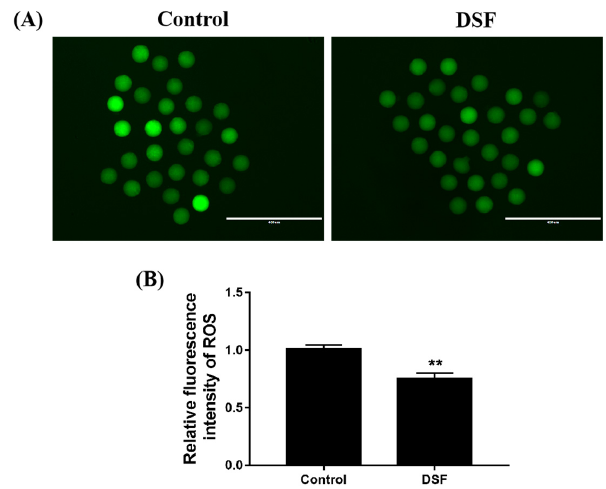
Figure 6. Effect of DSF on ROS level of mouse oocytes. ( A ) Representative images of ROS staining in the control and DSF groups; ( B ) the relative fluorescence intensity of ROS in the control and DSF groups. ** p < 0.01; scale bar = 400 μ m. Each test evaluated at least 30 MII oocytes in each group, and repeated 3 times.